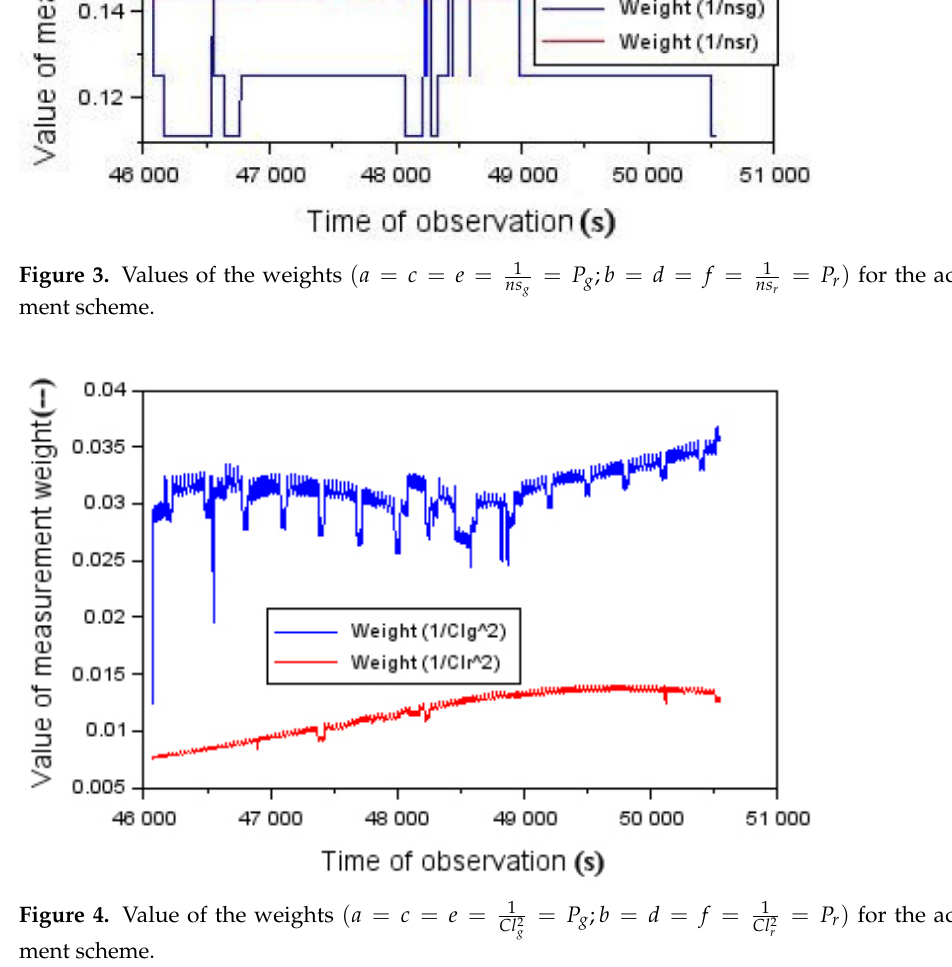
Figure 3. Values of the weights for the adjustment